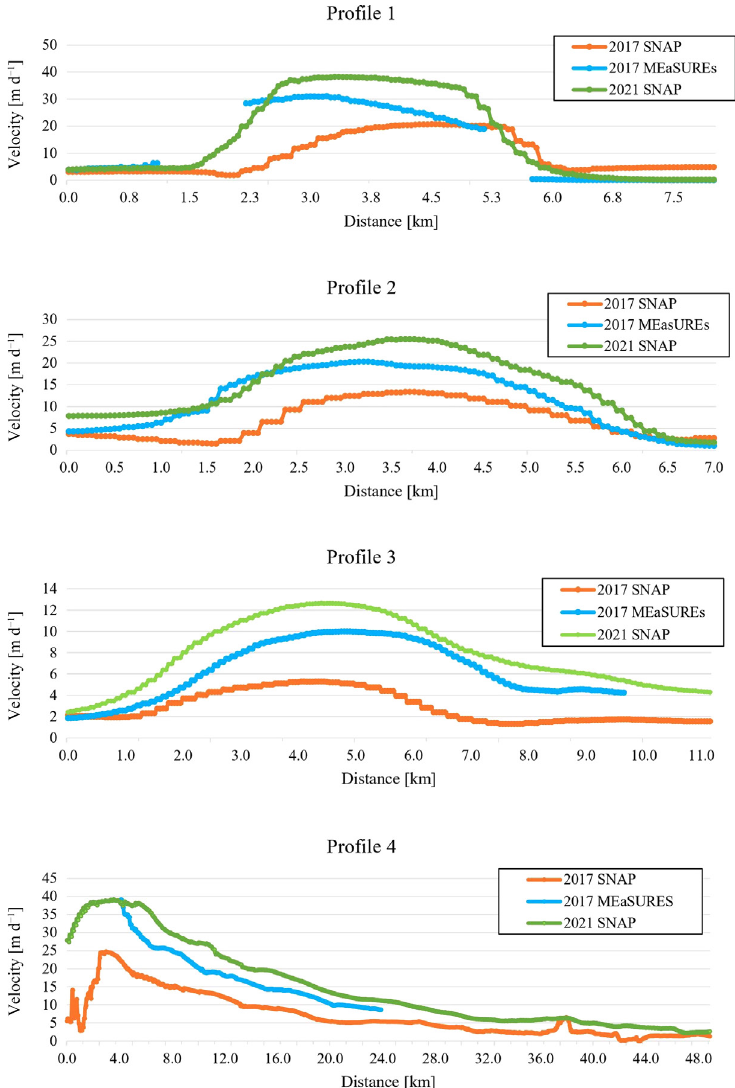
Fig. 11. Summer profiles presenting velocity